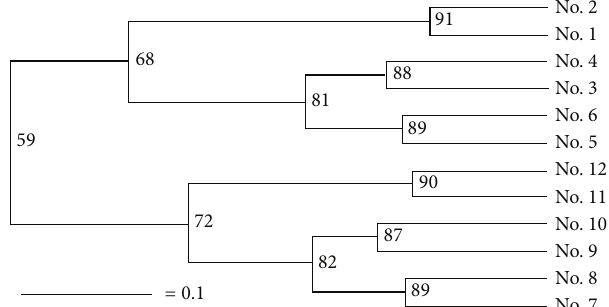
Figure 3: Phylogeny of the soil microflora, derived from 18S rDNA DGGE profiles. No. 1–no. 6: bulk soil samples and no. 7–no. 12: rhizosphere samples. No. 1, no. 2, no. 7, and no. 8: soil from plants at the seedling stage, no. 3, no. 4, no. 9, and no. 10: at the vegetative stage, and no. 5, no. 6, no. 11, and no. 12: at the reproductive